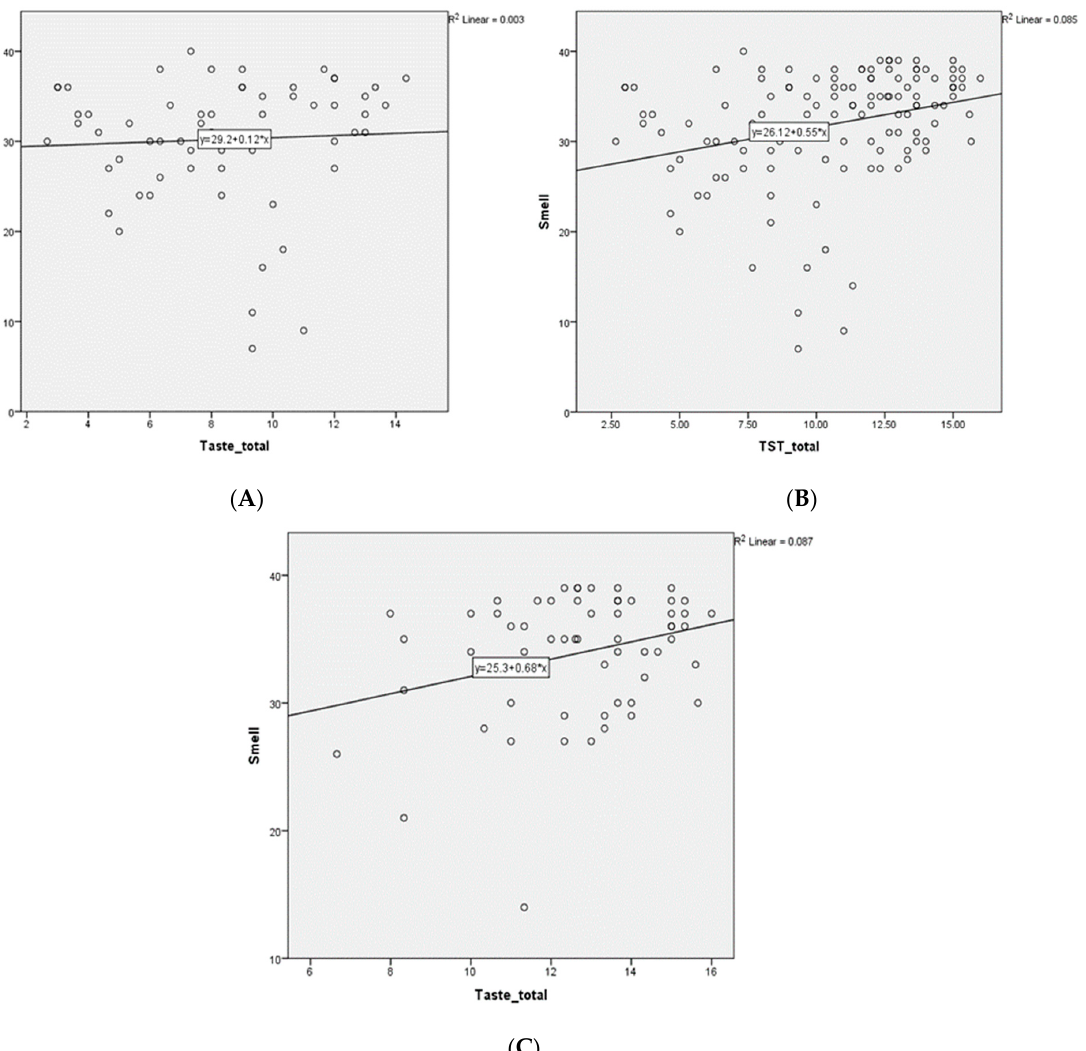
Figure 1. Correlation between smell and taste functions in the study. ( A ) Patients’ group; ( B ) Healthy participants’ group; ( C ) Total population of the study (patients and